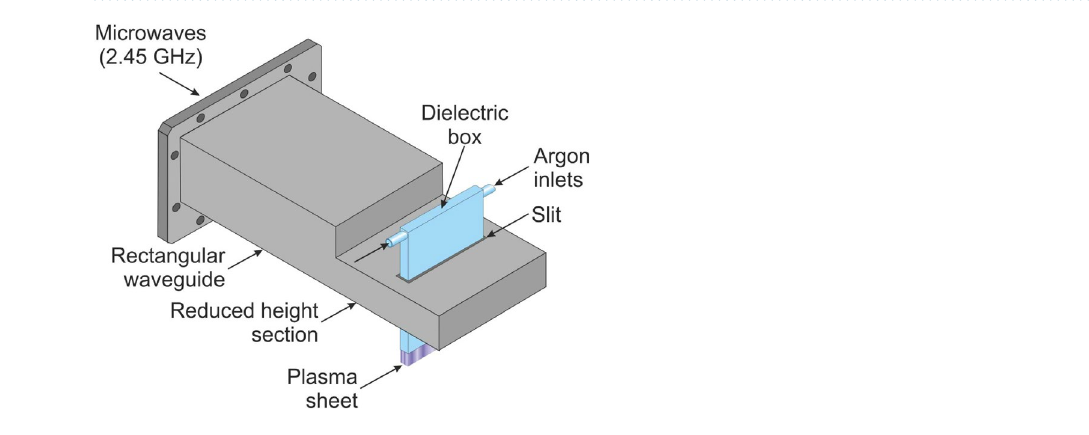
Figure 3. Schematic drawing of the microwave plasma sheet